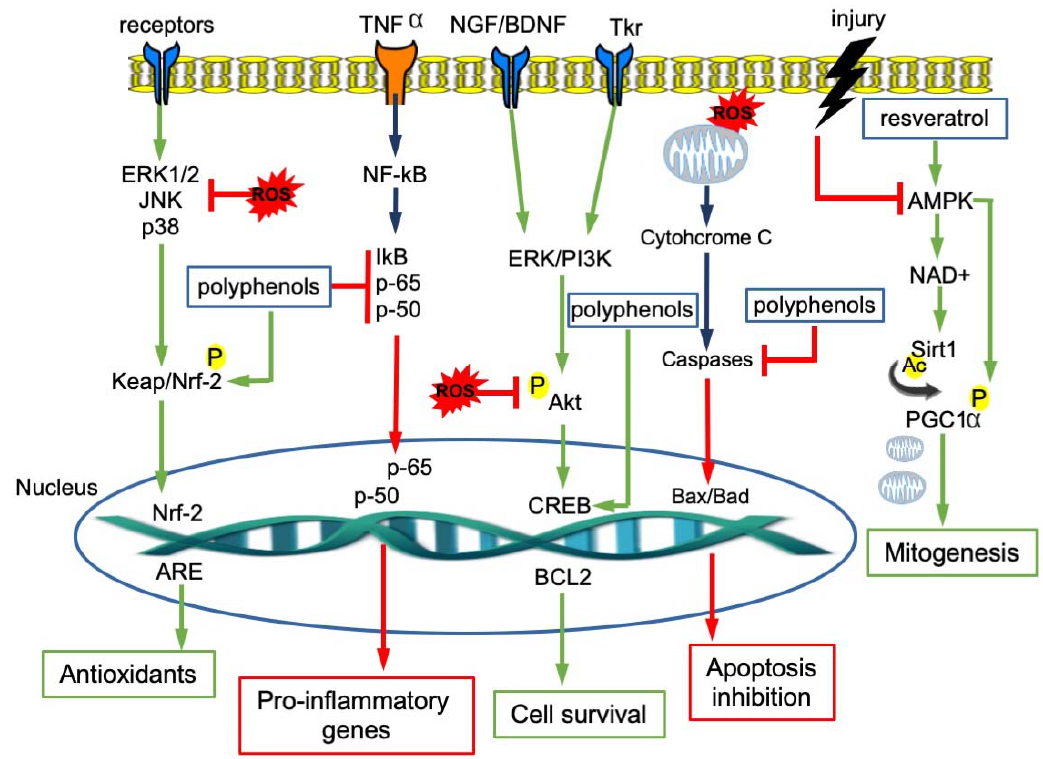
Figure 2. Intracellular signaling pathways involved in neuroprotection and modulated by polyphenols.